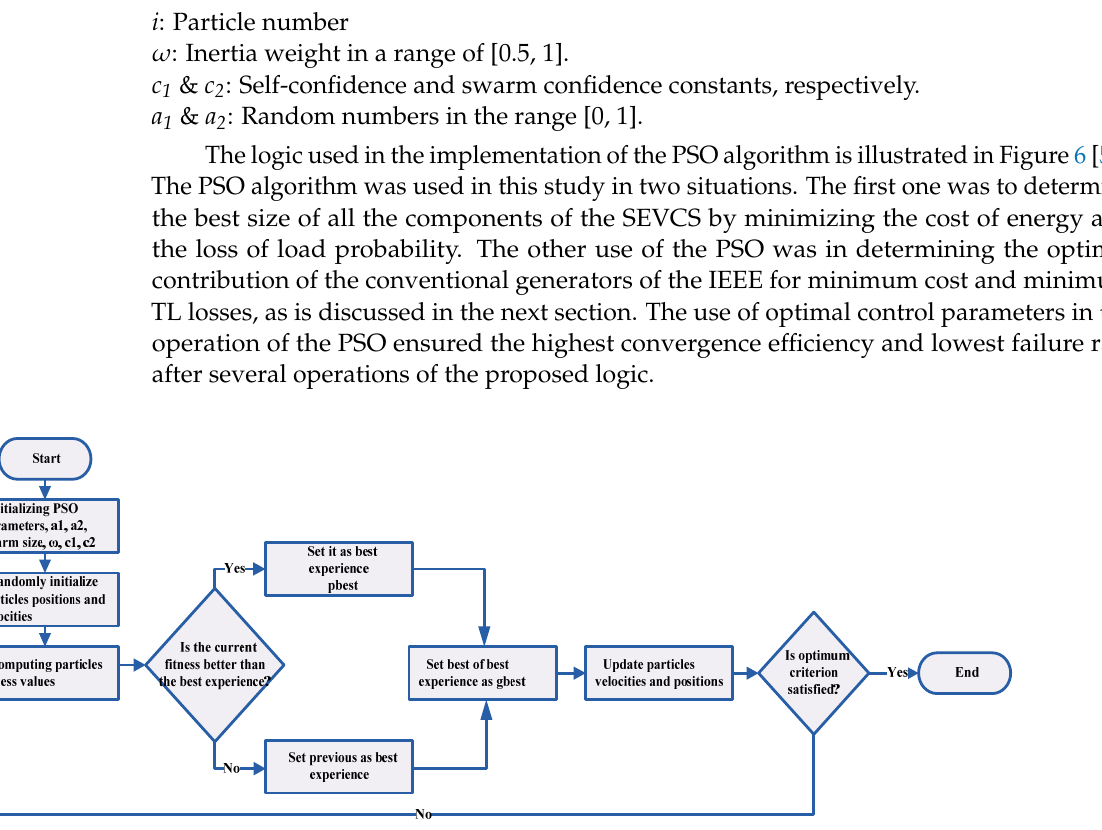
Figure 6. The process of the PSO algorithm.